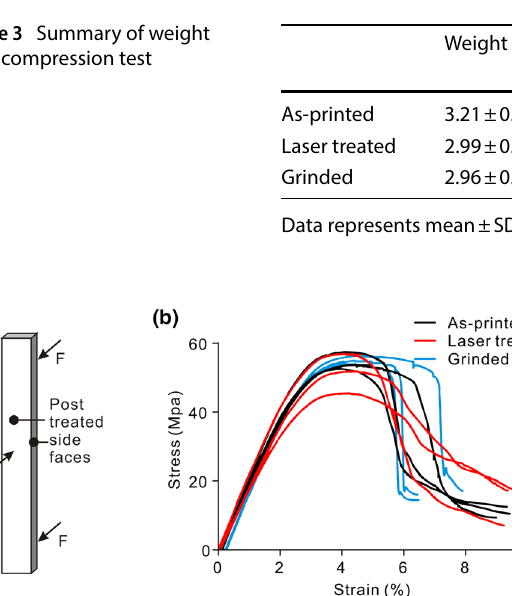
Table 3 Summary of weight and compression test